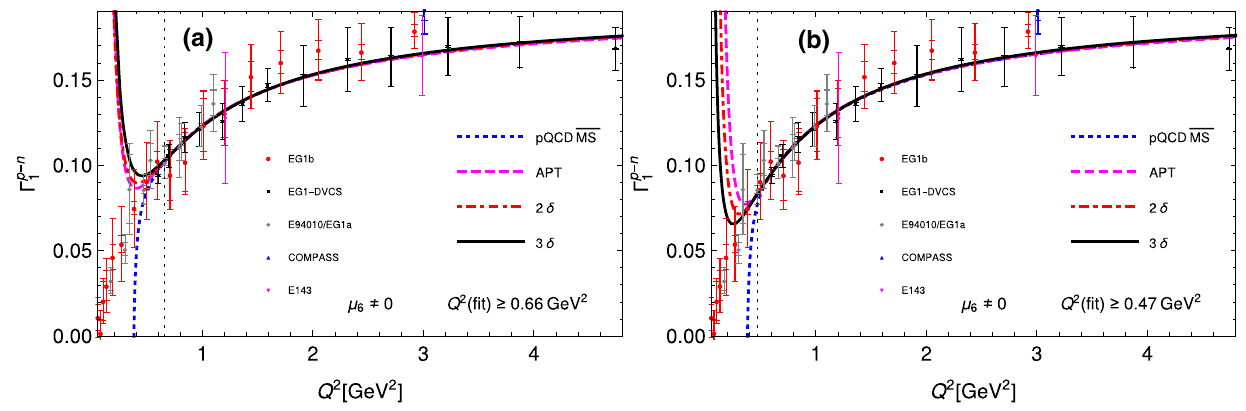
Fig. 2 Fits of the OPE expression (10) truncated at D = 4 term (i.e., μ (cid:8)= 0), to the experimental data for (cid:2) p − n 4 ferent QCD variants, where in the fits: a left plot, Q 2 ≥ 0 . 66 GeV 2 ;